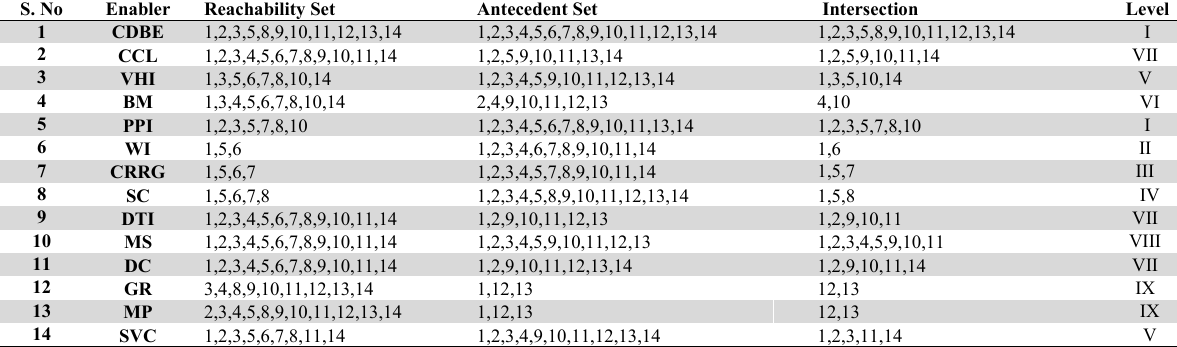
Consolidated table of level partitioning of elements S.